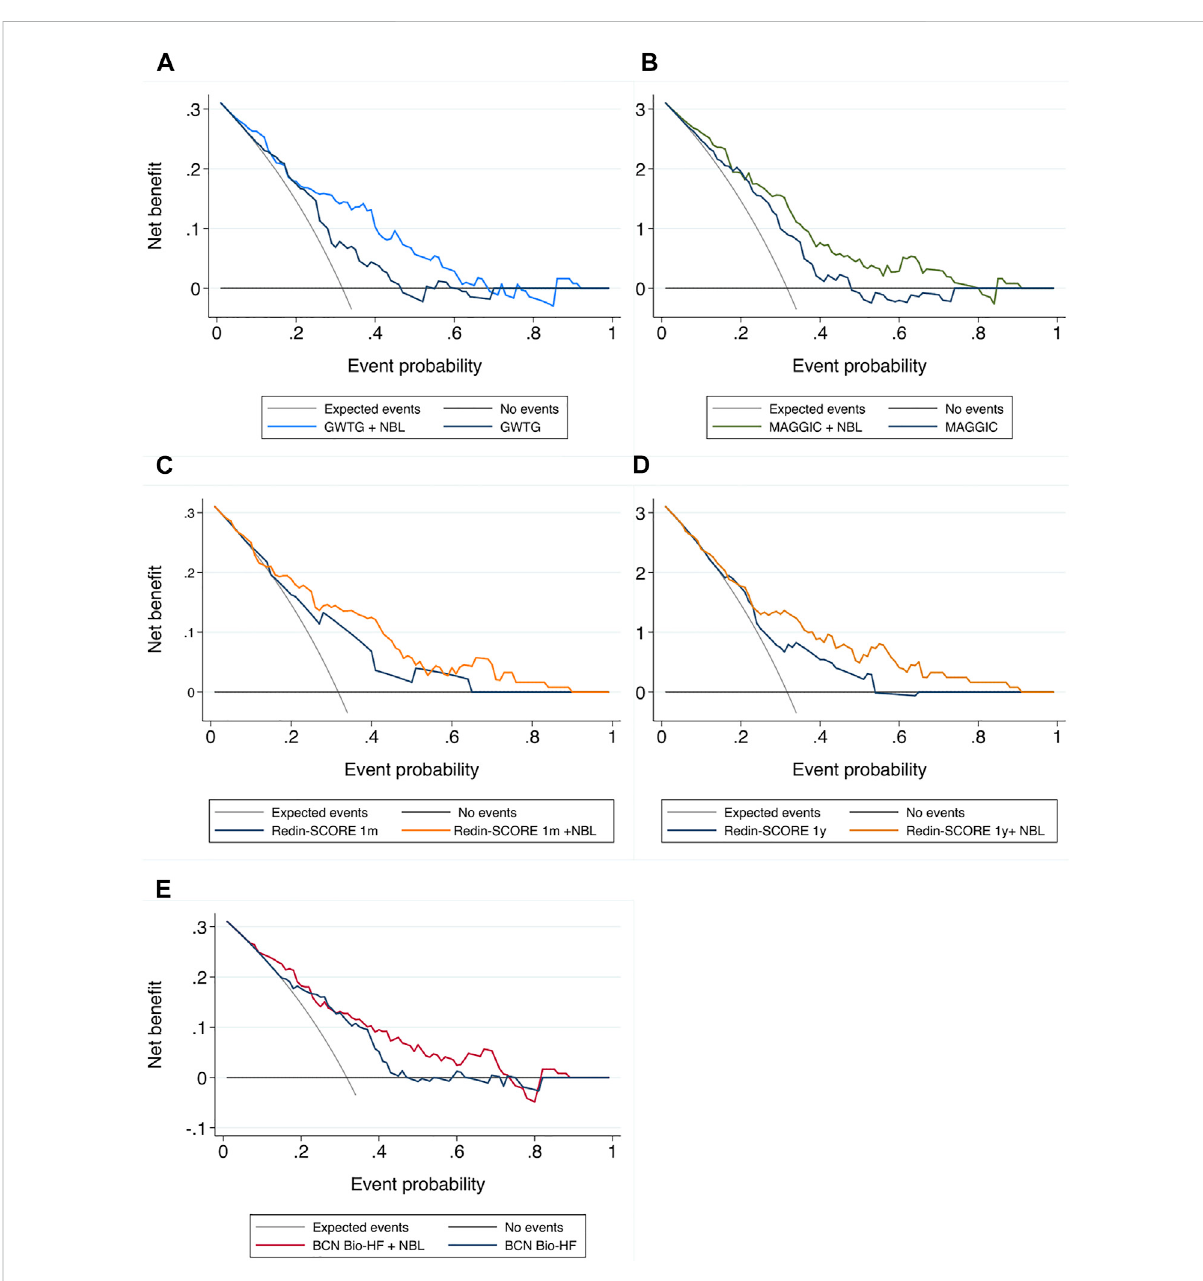
FIGURE 2 Calibration plots. X-axis: predicted outcome; Y-axis: observed outcome. NBL: number of B lines (A) GWTG: Get With the Guidelines score; (B) MAGGIC score; (C) Redin-SCORE 1 month; (D) Redin-SCORE 1 year; (E) BCN Bio-HF